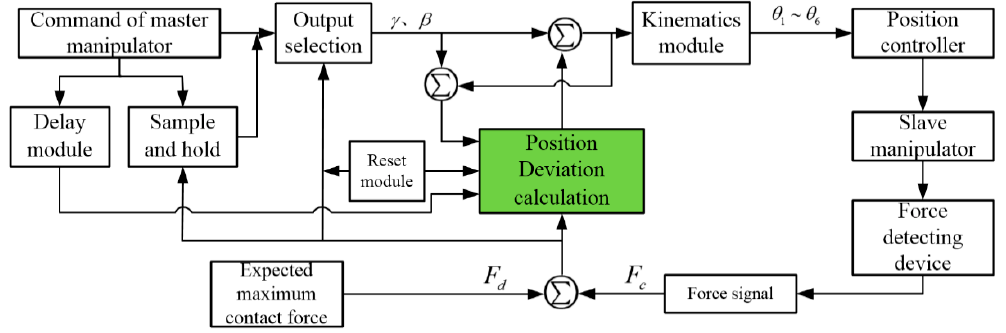
Figure 13. Working principle of the impedance control module.